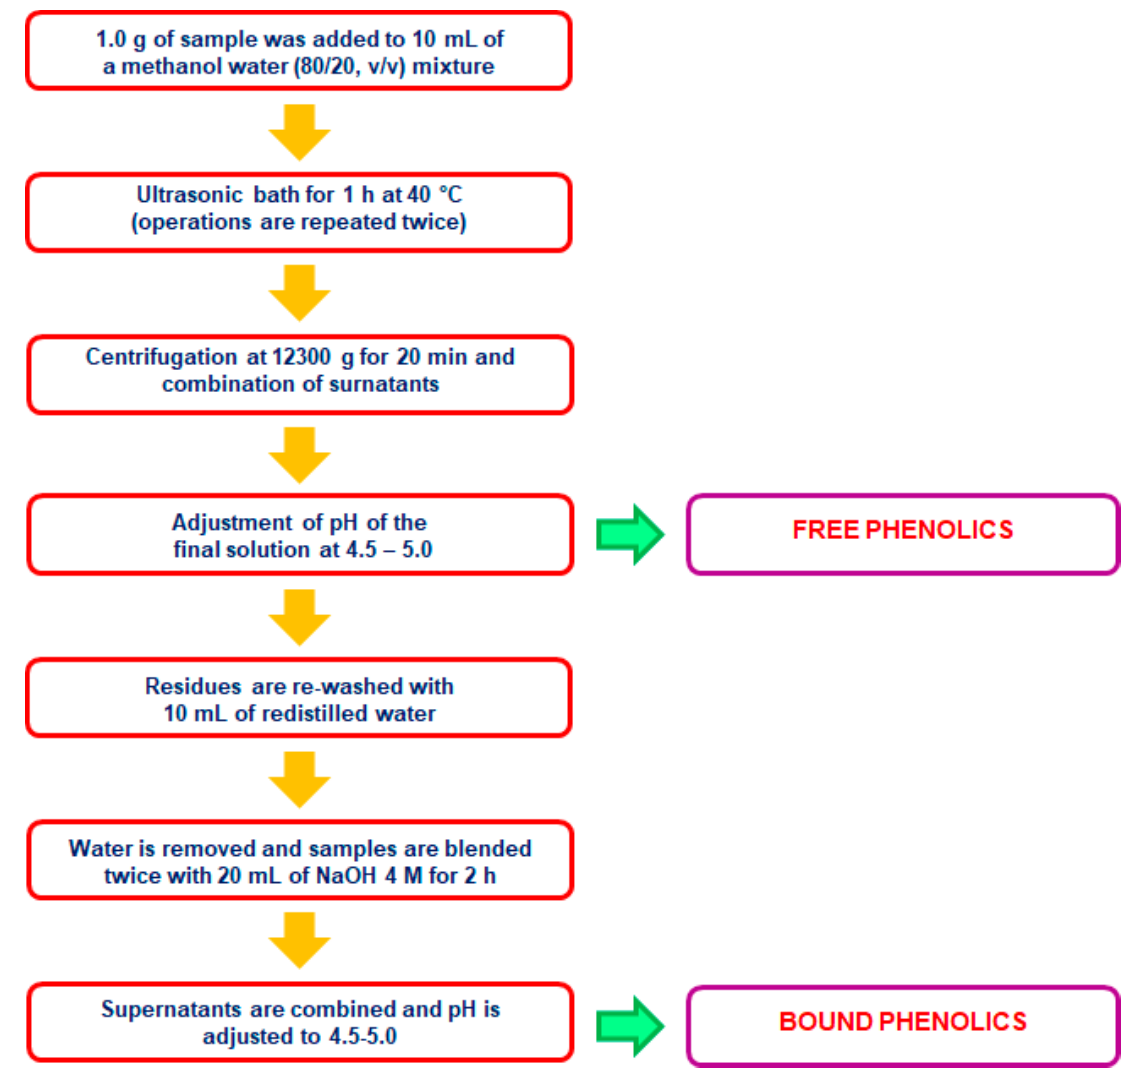
Figure 4. Extraction of free and bound phenolics as described by Sumczynski et al. (2017) [14].